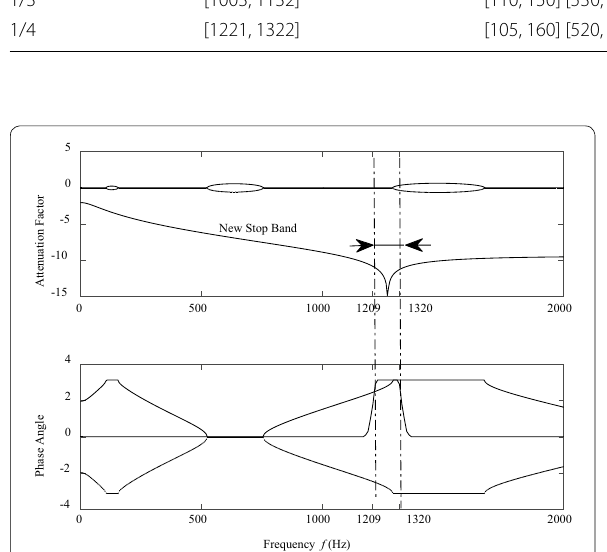
Figure 5 Numerical Propagation Characteristics derived at 1500 r/min